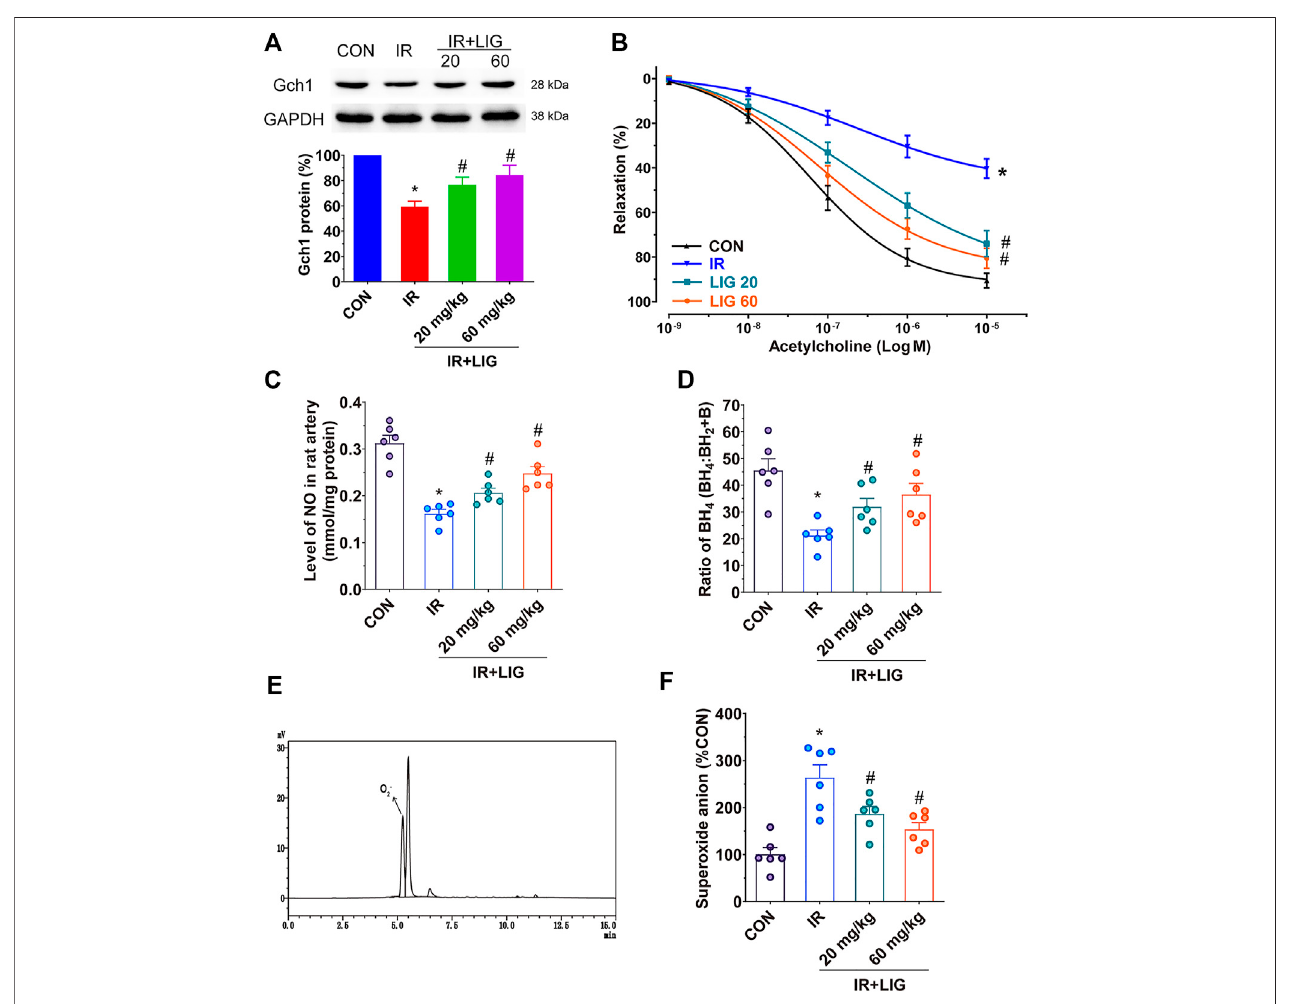
FIGURE 3 | Effects of LIG on Gch1 protein levels, vasodilatory functions and BH 4 levels in IR-exposed rat mesenteric arteries. Rats received 4 Gy of IR and intraperitonealinjectionofLIGdailyfor3weeks(20or60 mg/kg). (A) Representativeimmunoblotsandquanti fi cationasbanddensitiesshowingphosphorylationofGch1 withGAPDHasaloadingcontrolinratmesentericarteries( n (cid:1) 4). (B) Receptor-mediatedendothelium-dependentvasodilationafteracetylcholinetreatment.Aorticrings were precontracted with U46619 (100 nM). (C) The total amount of NO in the mesenteric arteries was determined by a total NO assay kit. (D) Ratio of BH 4 to BH 2 +B in rat mesenteric arteries. (E) Representative chromatogram of superoxide anions detected by HPLC coupled with fl uorescence detection in rat mesenteric arteries. (F) Relative quantitation of superoxide anions in rat mesenteric arteries. Data are the mean ± SEM; n (cid:1) 6. * p < 0.05, signi fi cantly different from the CON group; # p < 0.05, signi fi cantly different from the IR